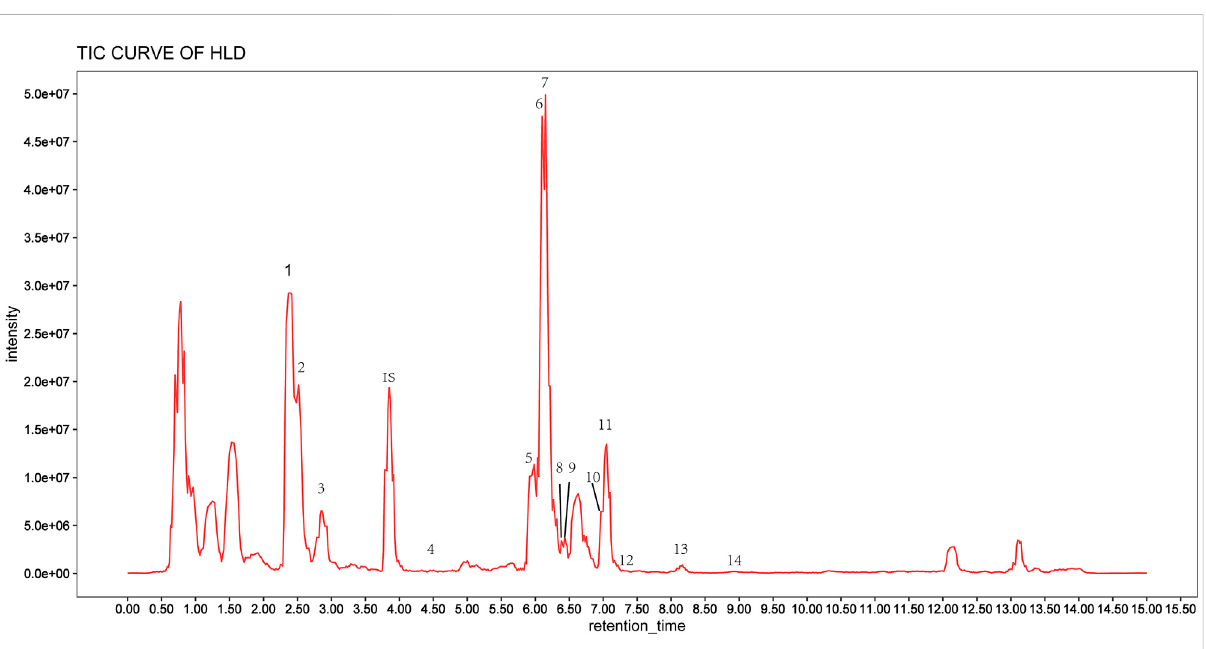
FIGURE 2 LC-MS chromatogram of